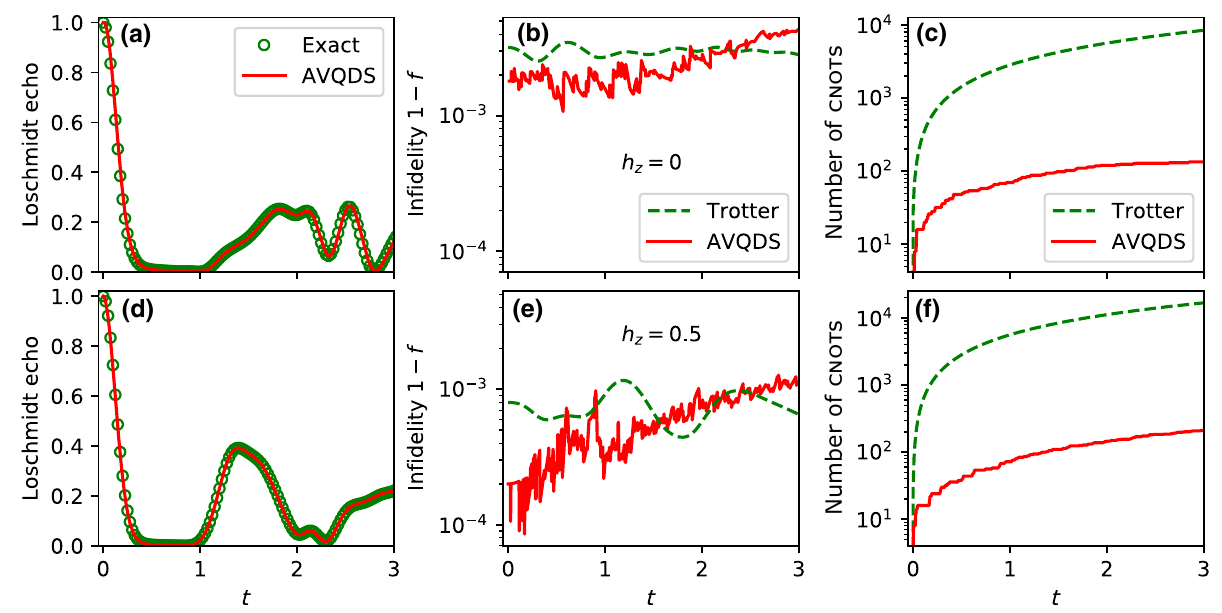
FIG. 6. Quench dynamics of eight-site mixed-field Ising model with periodic boundary conditions. The time-dependent Loschmidt echo, infidelity 1 − f ≡ 1 − |(cid:4) (cid:4) [ θ ( t ) ] | (cid:4) exact ( t ) (cid:3)| 2 , and number of CNOT s N cx are plotted in the upper panels for h z = 0 (integrable), and the lower panels for h z = 0.5 (nonintegrable). The Loschmidt echoes (return probabilities) in (a),(d) from AVQDS show excellent agreement with exact calculations. The infidelity plots in (b),(e) further quantify the AVQDS accuracy with a fidelity ≥ 99.5%. As shown in (c),(f), Trotter circuits are about 2 orders of magnitude deeper than AVQDS circuits for similar simulation accuracies,